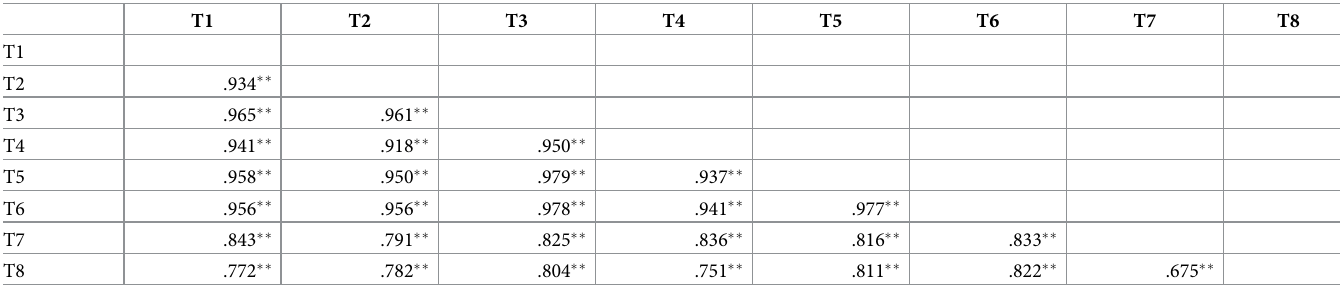
Table 6. Matrix of correlation between variables on